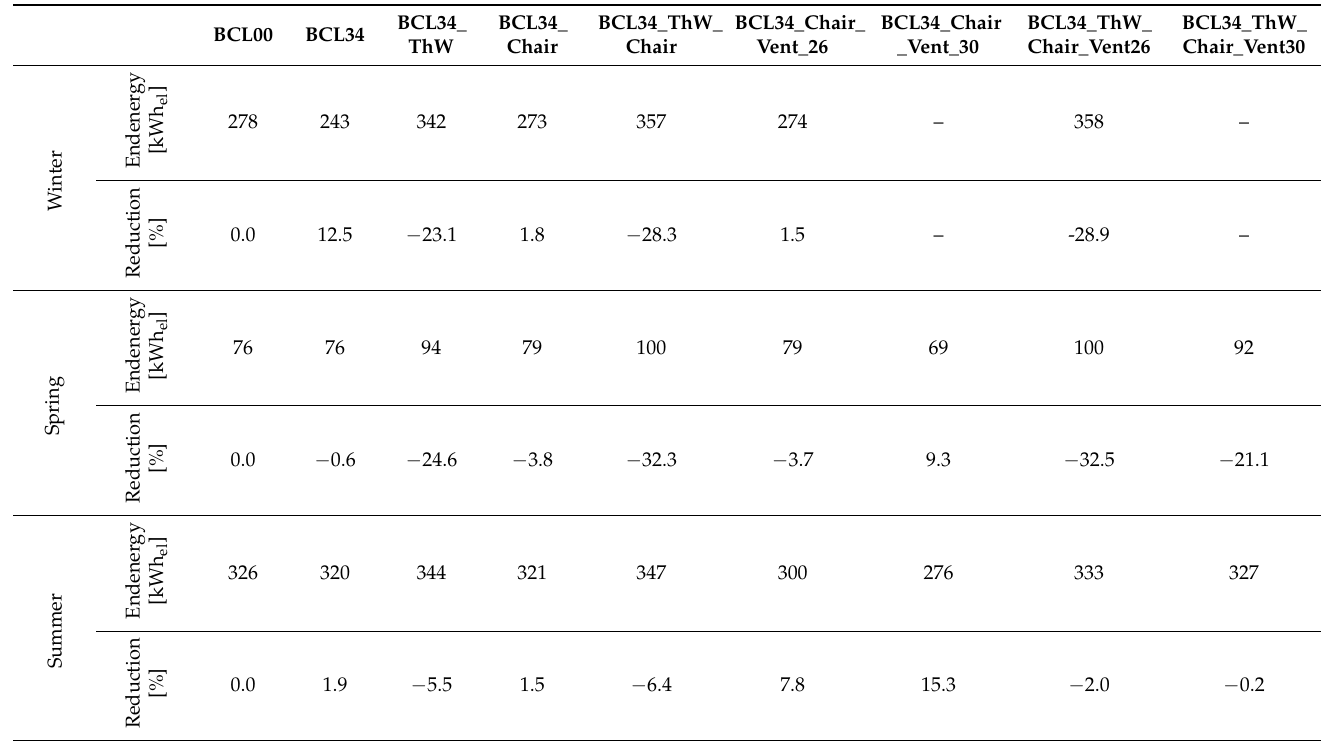
Table 7. Summary and comparison of the used end energy of the different controllers with the thermoelectric wall (ThW), chair, and fan (Vent); 26 and 30 represent the upper setpoint temperature TU ( ◦